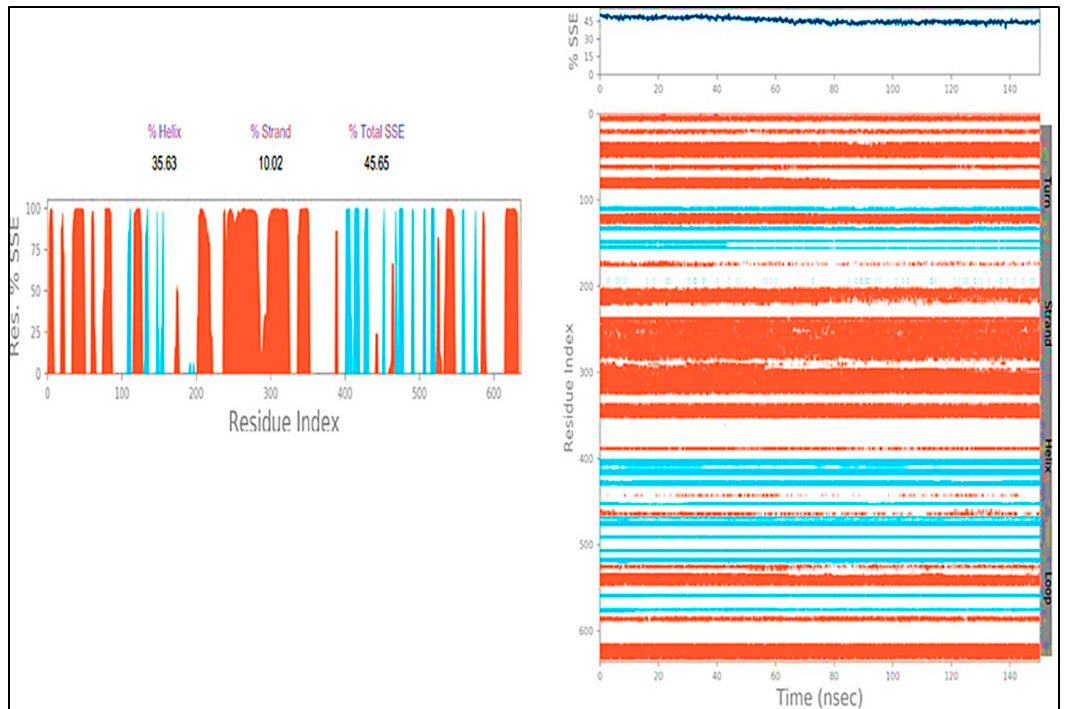
Figure 21. Secondary Structure element distribution by residue index throughout the protein structure. Red indicates alpha helices, and blue indicate beta-strands of; LSD-compound 1 .